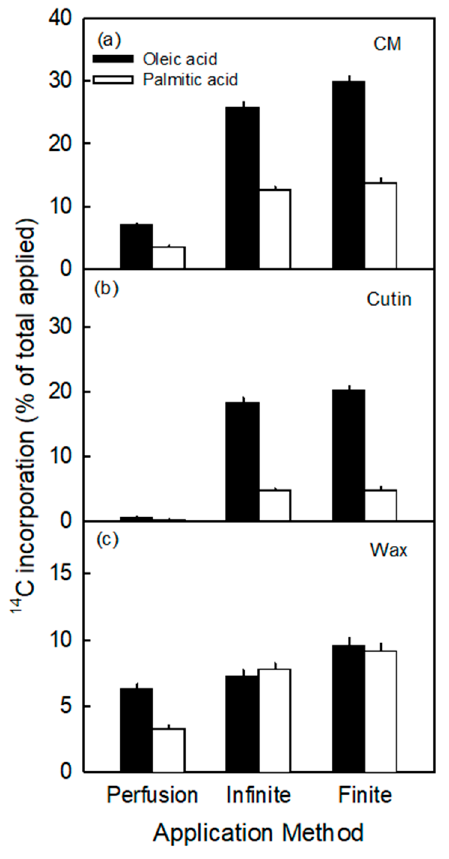
Figure 2. Incorporation of 14 C (% of total applied) of oleic acid and palmitic acid in cuticular membrane (CM) ( a ), cutin ( b ) and wax ( c ) as affected by application method. 14 C labelled oleic or palmitic acid was applied to the excised exocarp segments (ES) of young fruit of ‘Idared’ apples sampled at 43 days after full bloom (DAFB). The values are means ± SEs of 15 replications.